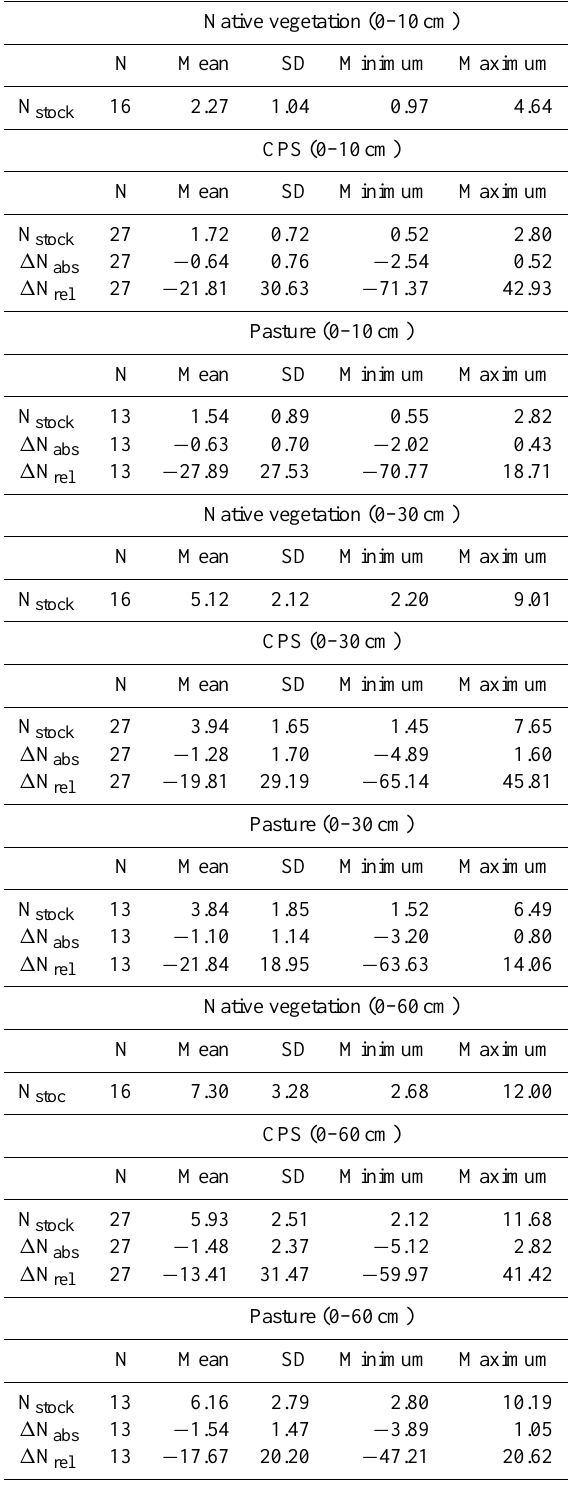
Table 2. Mean, standard deviation (SD), and minimum and maximum of soil nitrogen stocks (N stock , expressed as Mgha − 1 ) at 0–10, 0–30, and 0–60cm soil depth layer for forest, crop–livestock systems and pasture soils at the paired study sites. (cid:49) N abs is the difference between the soil nitrogen stock of native vegetation and crop livestock systems and pasture soils obtained in the paired study sites (expressed as Mgha − 1 ) . (cid:49) N rel is the same difference expressed as a percentage. Nitrogen losses are indicated by a minus sign ( −